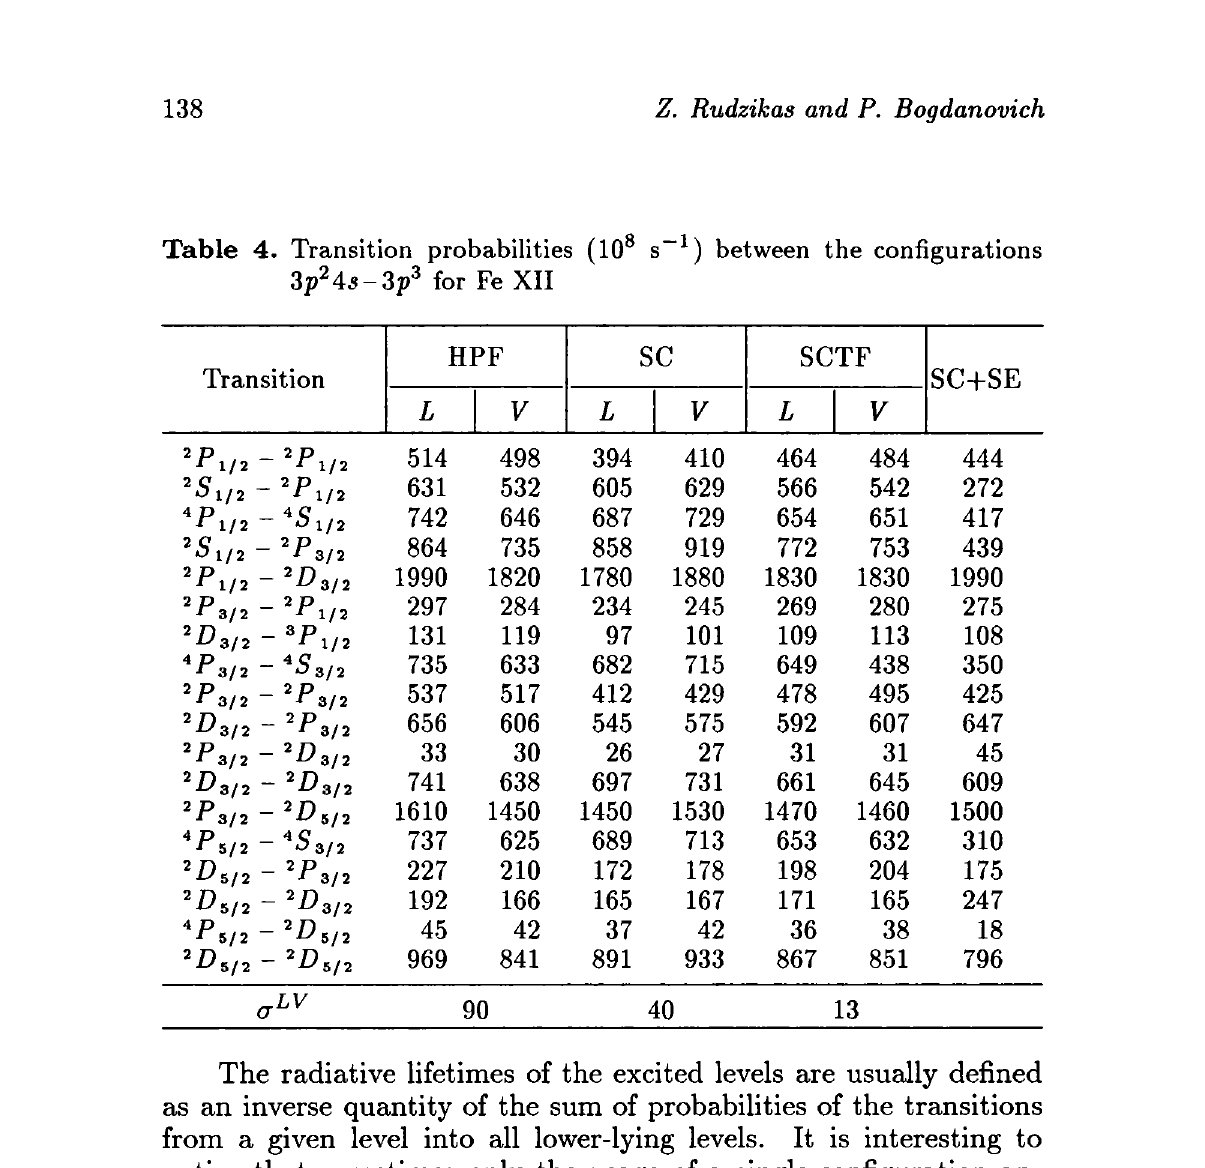
Table 4. Transition probabilities (10 8 s 1 ) between the